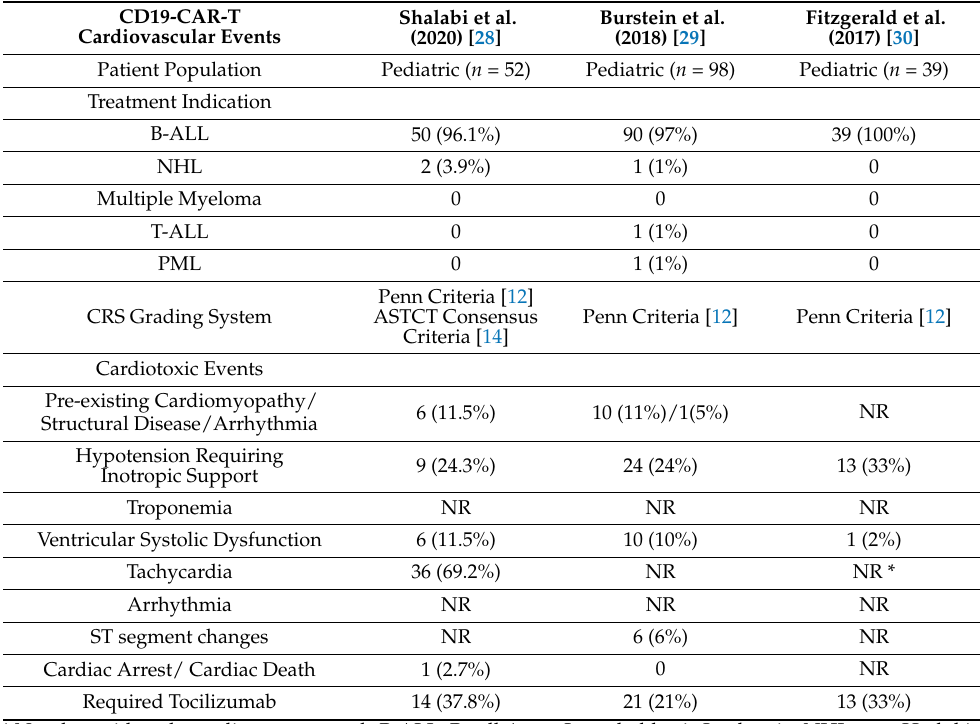
Table 5. Summary of cardiotoxicity in retrospective pediatric